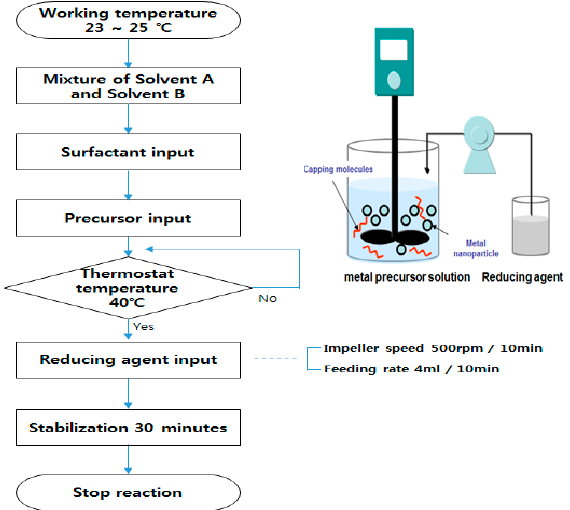
Figure 1. Synthesis of metal nanoparticles.